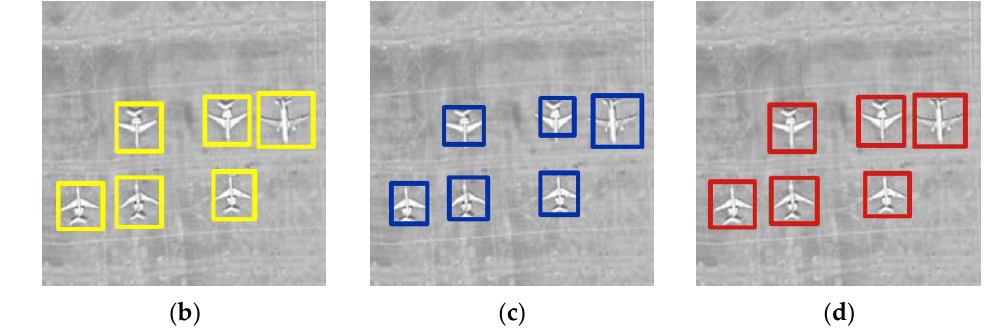
Figure 6. Comparison experiment results of our method with the YOLOv5 baseline: ( a ) input RSIs (partial areas marked by the white boxes), ( b ) partially enlarged RSIs with ground truth (represented by the yellow boxes), ( c ) YOLOv5 results (represented by the blue boxes), and ( d ) L-SNR-YOLO results (represented by the red boxes).